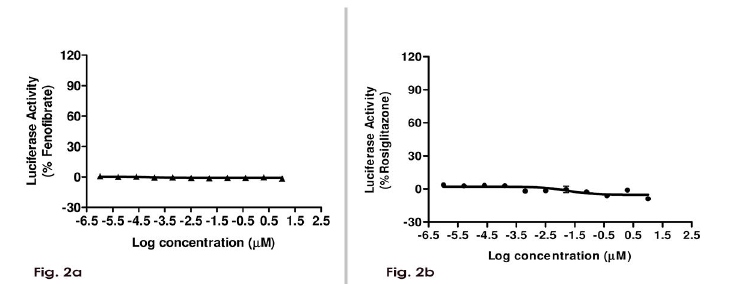
Figure 2. P1736 does not activate human Peroxisome Proliferator Activated Receptors (PPAR). a , P1736 was added to HEK-293 cells expressing ligand binding domain of human PPARα receptor and the transactivation ability was assayed using renilla luciferase activity. Fenofibrate was used as the positive control. b , P1736 was added to HEK-293 cells expressing ligand binding domain of human PPARγ receptor and the transactivation ability was assayed using rosiglitazone as the positive control. doi: